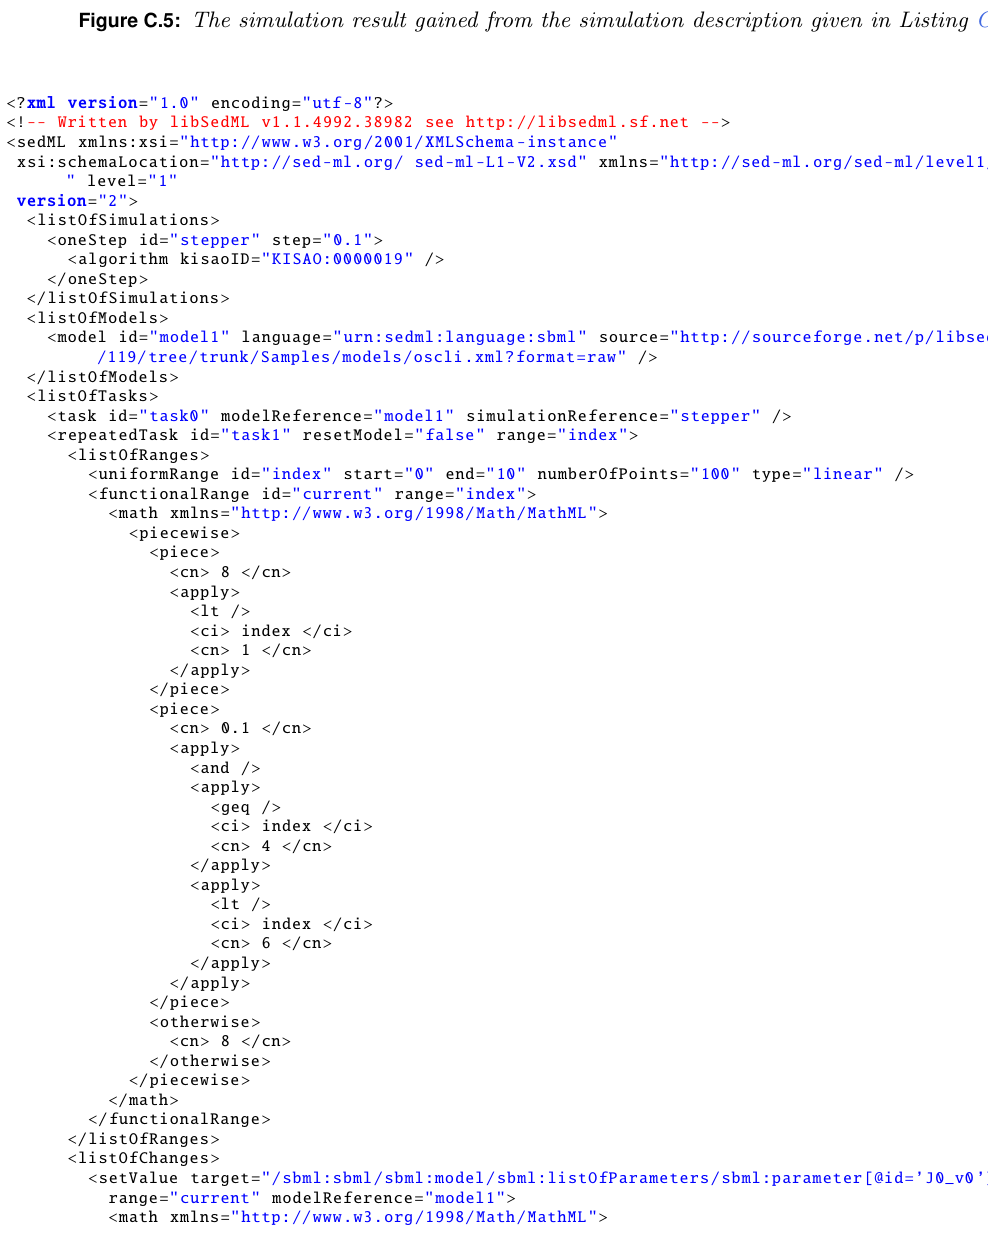
Figure C.5: The simulation result gained from the simulation description given in Listing